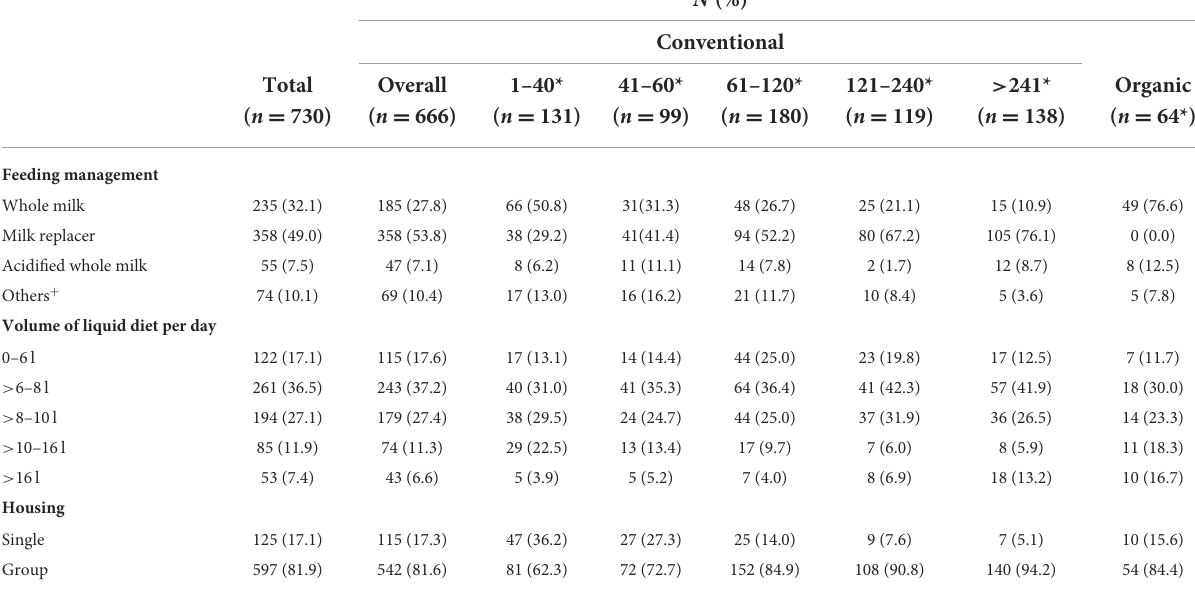
TABLE 5 Feeding management and housing conditions of preweaned dairy calves from the 3rd week of life on 730 German dairies stratified by herd size and farm